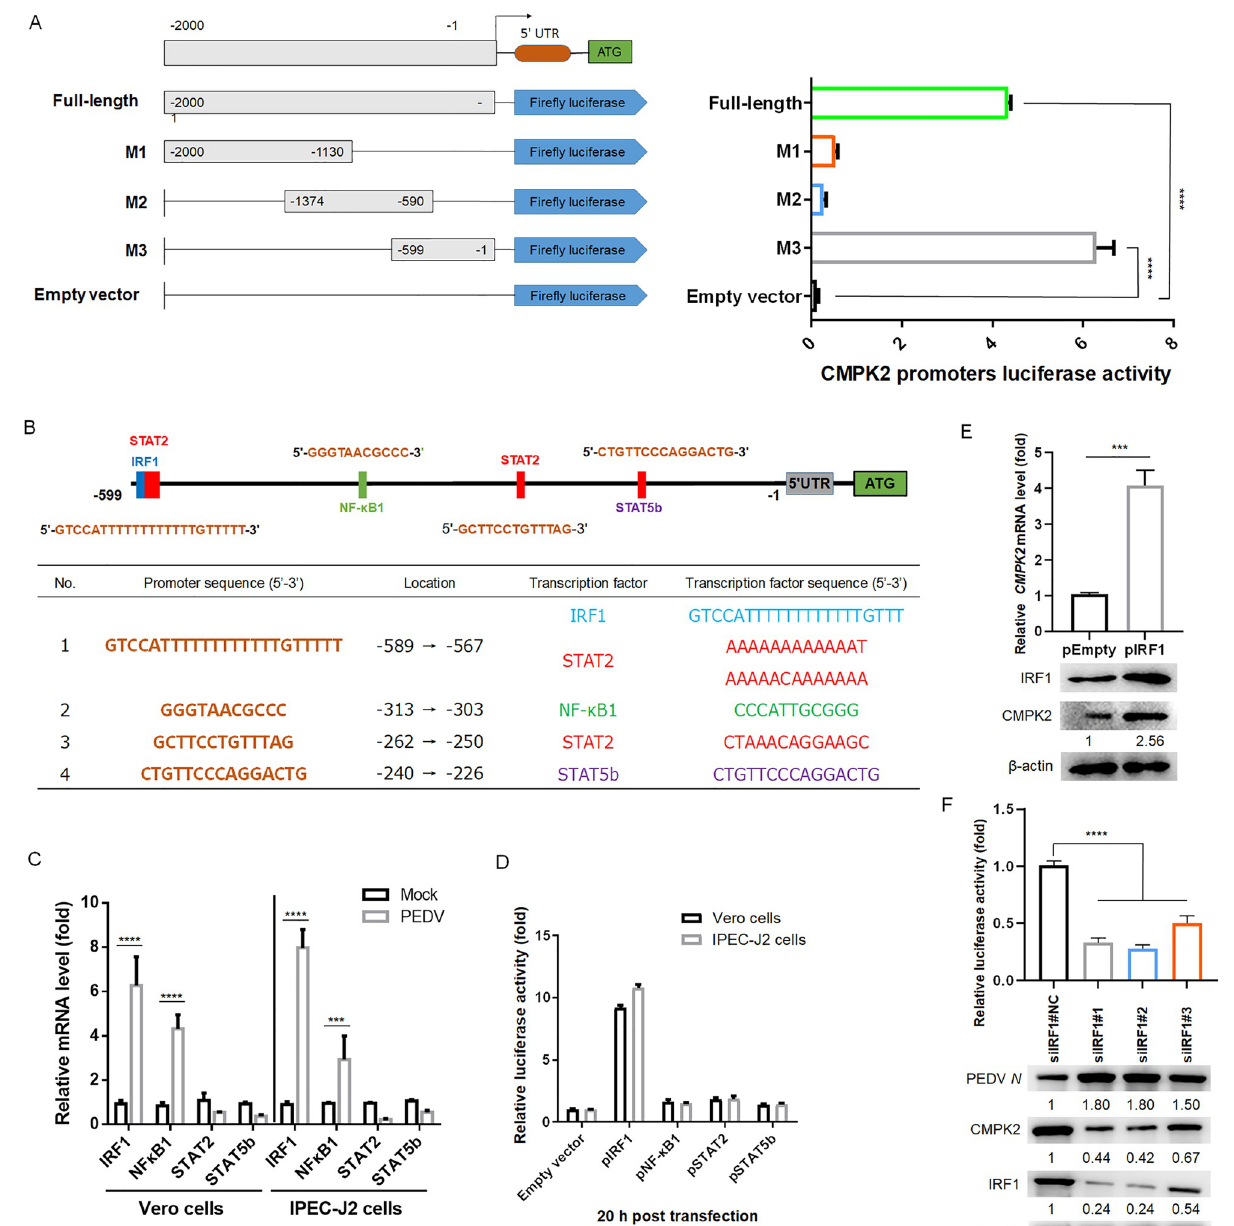
Fig 3. IRF1 directly controls the transcription of CMPK2. (A) Full-length CMPK2 promoter (nucleotides − 2,000 to − 13) and a series of truncated CMPK2 promoter mutants (M1 to M3) cloned into the pGL3-Basic vector. IPEC-J2 cells were cotransfected with the full-length or truncated promoter– reporter constructs, together with the Renilla luciferase reporter vector (pRL-TK-luc) as an internal control. Samples were collected at 20 h post- transfection and analyzed for dual luciferase activities. (B) Regulatory elements in the CMPK2 promoter region were predicted with the JASPAR vertebrate database (http://jaspar.genereg.net/). Different colors indicate different putative regulatory elements. (C) Vero cells and IPEC-J2 cells were infected or mock-infected with PEDV (MOI = 1) and harvested at 20 hpi. The expression of putative transcription factors was analyzed by qRT-PCR. (D) IPEC-J2 cells were transfected with CMPK2 promoter-driven luciferase vector, pRL-TK-luc vector, and plasmids encoding Flag-tagged putative transcription factors. Samples were collected at 20 h post-transfection and analyzed for dual luciferase activity. (E and F) IPEC-J2 cells were transfected with either plasmid encoding Flag-IRF1 (pIRF1) or siRNA#1 silencing IRF1 and then infected with PEDV at MOI of 1. qRT-PCR and western blotting were performed to measure the levels of CMPK2 expression and PEDV replication. Data are means ± SD of triplicate samples; statistical analysis was conducted using one-way ANOVA followed by Dunnett’s multiple comparison test or two-way ANOVA followed by Tukey’s multiple comparison test; only the p -value for the most relevant comparisons are shown for simplicity. ��� p < 0.001, ���� p < 0.0001. Data underlying this figure can be found in S1 Data and S1 Raw Images. CMPK2, cytidine/uridine monophosphate kinase 2; hpi, hours post-infection; IRF1, interferon regulatory factor 1; MOI, multiplicity of infection; PEDV, porcine epidemic diarrhea virus; qRT-PCR, quantitative real-time PCR.